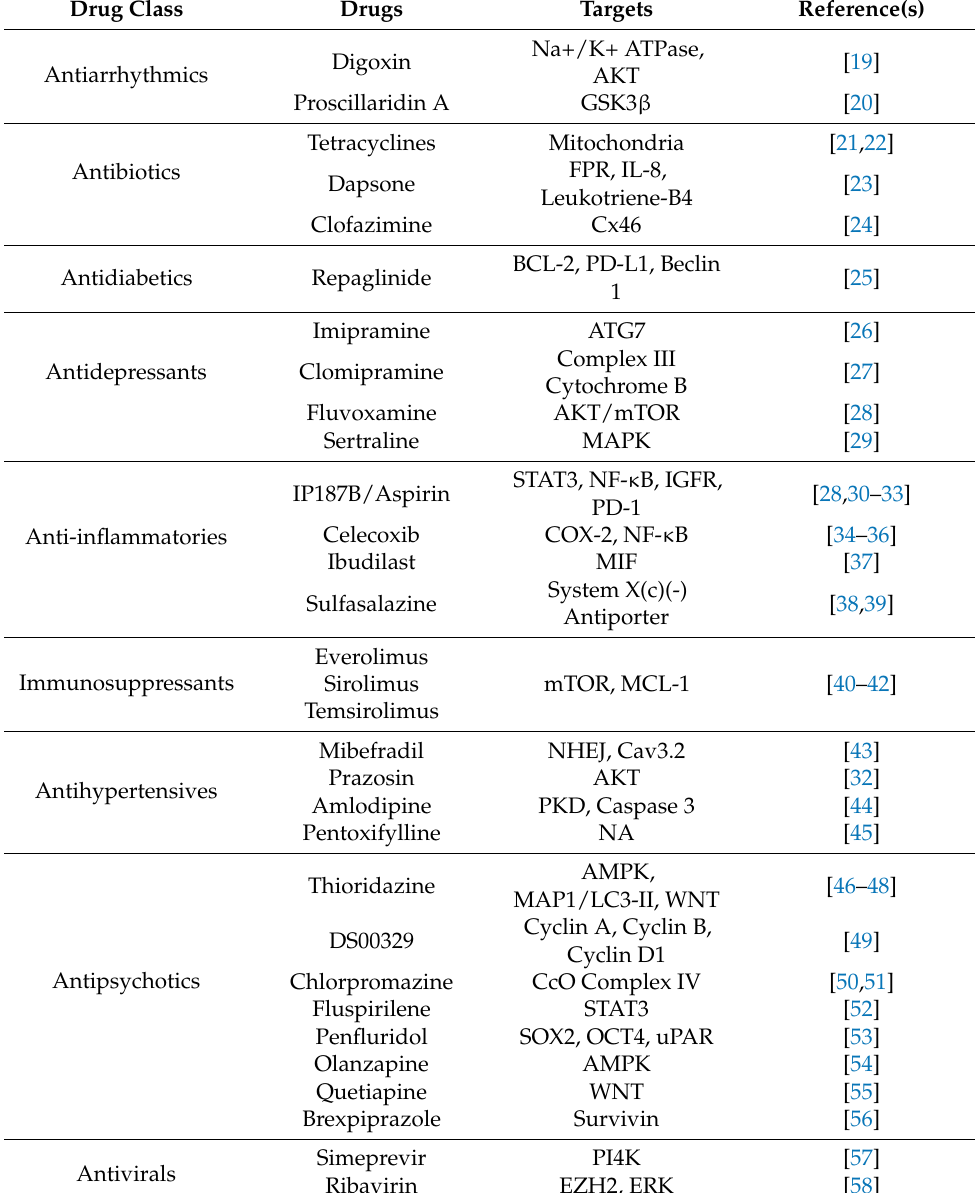
Table 1. Drug class, specific drug, and drug targets of repurposed agents currently undergoing preclinical